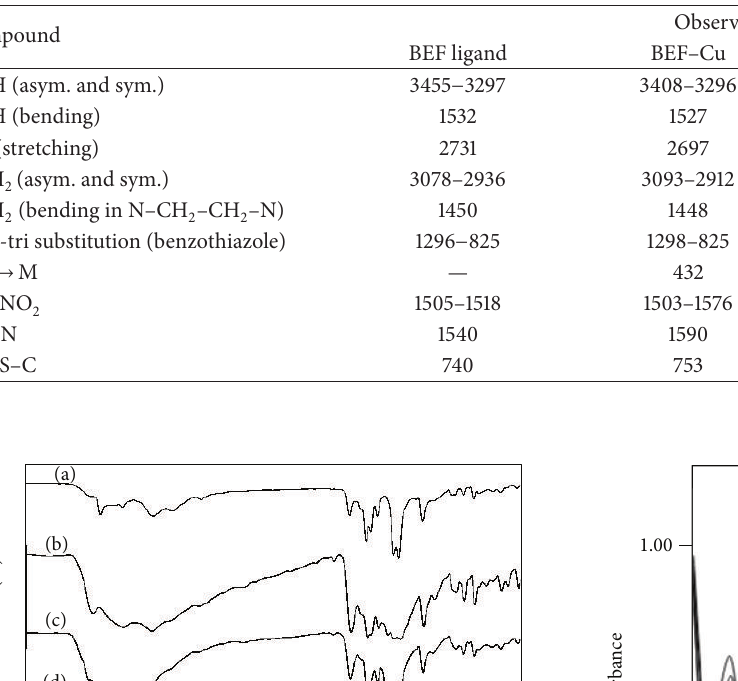
Table 2: FTIR data.